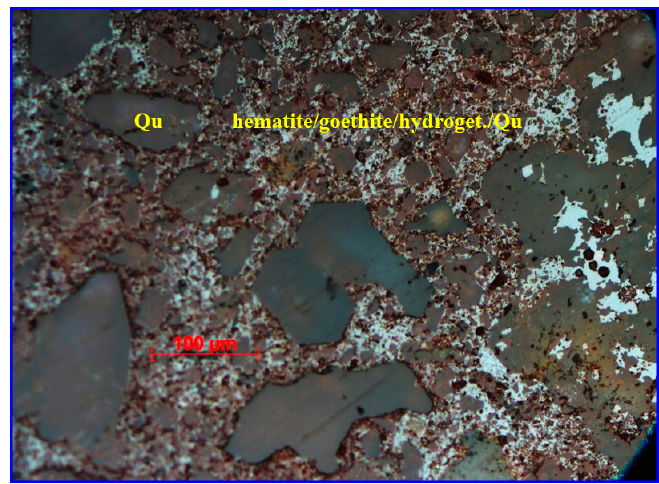
Figure 4. A section of the briquette residue after thermochemical activation and extraction of nonferrous metals with an area of S = 500 µ m × 700 µ m. Magnification × 200 times.